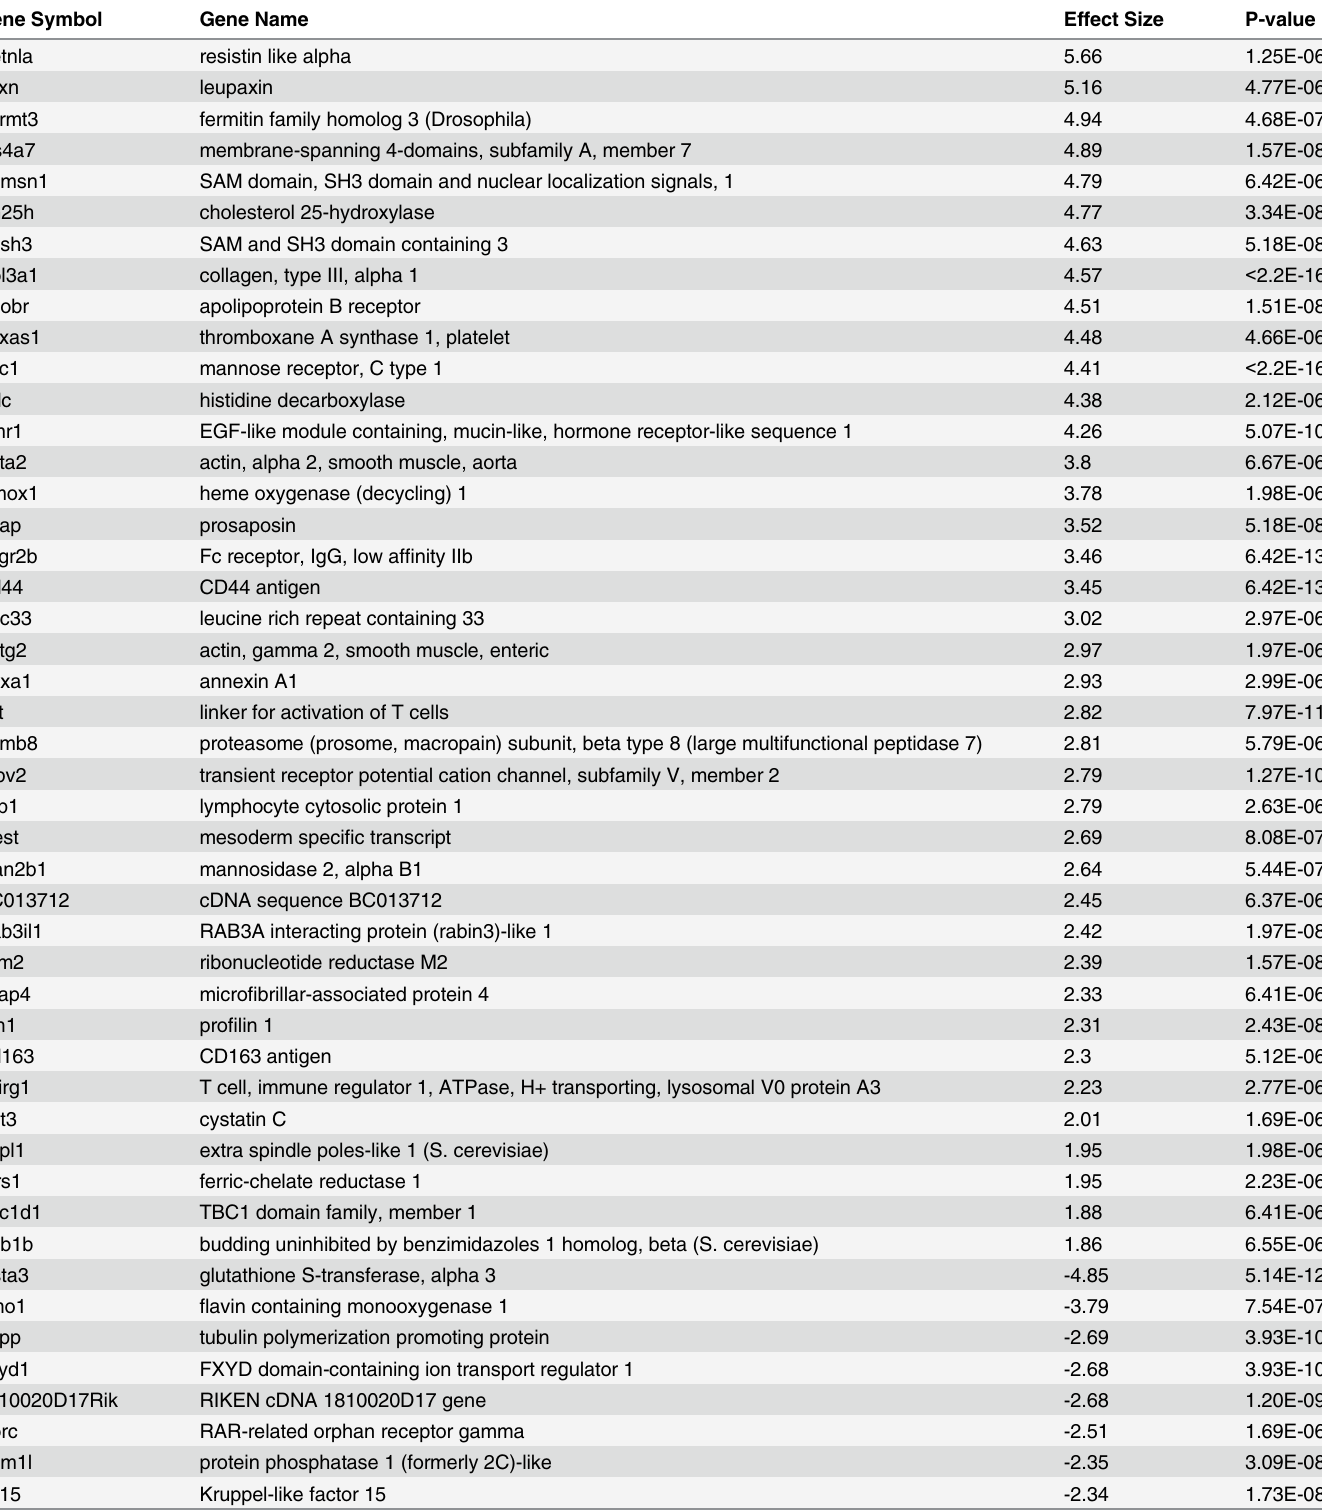
Table 2. The top 50 DE genes. The genes are ranked by their effect sizes and separated based on their directions of changes. Gene